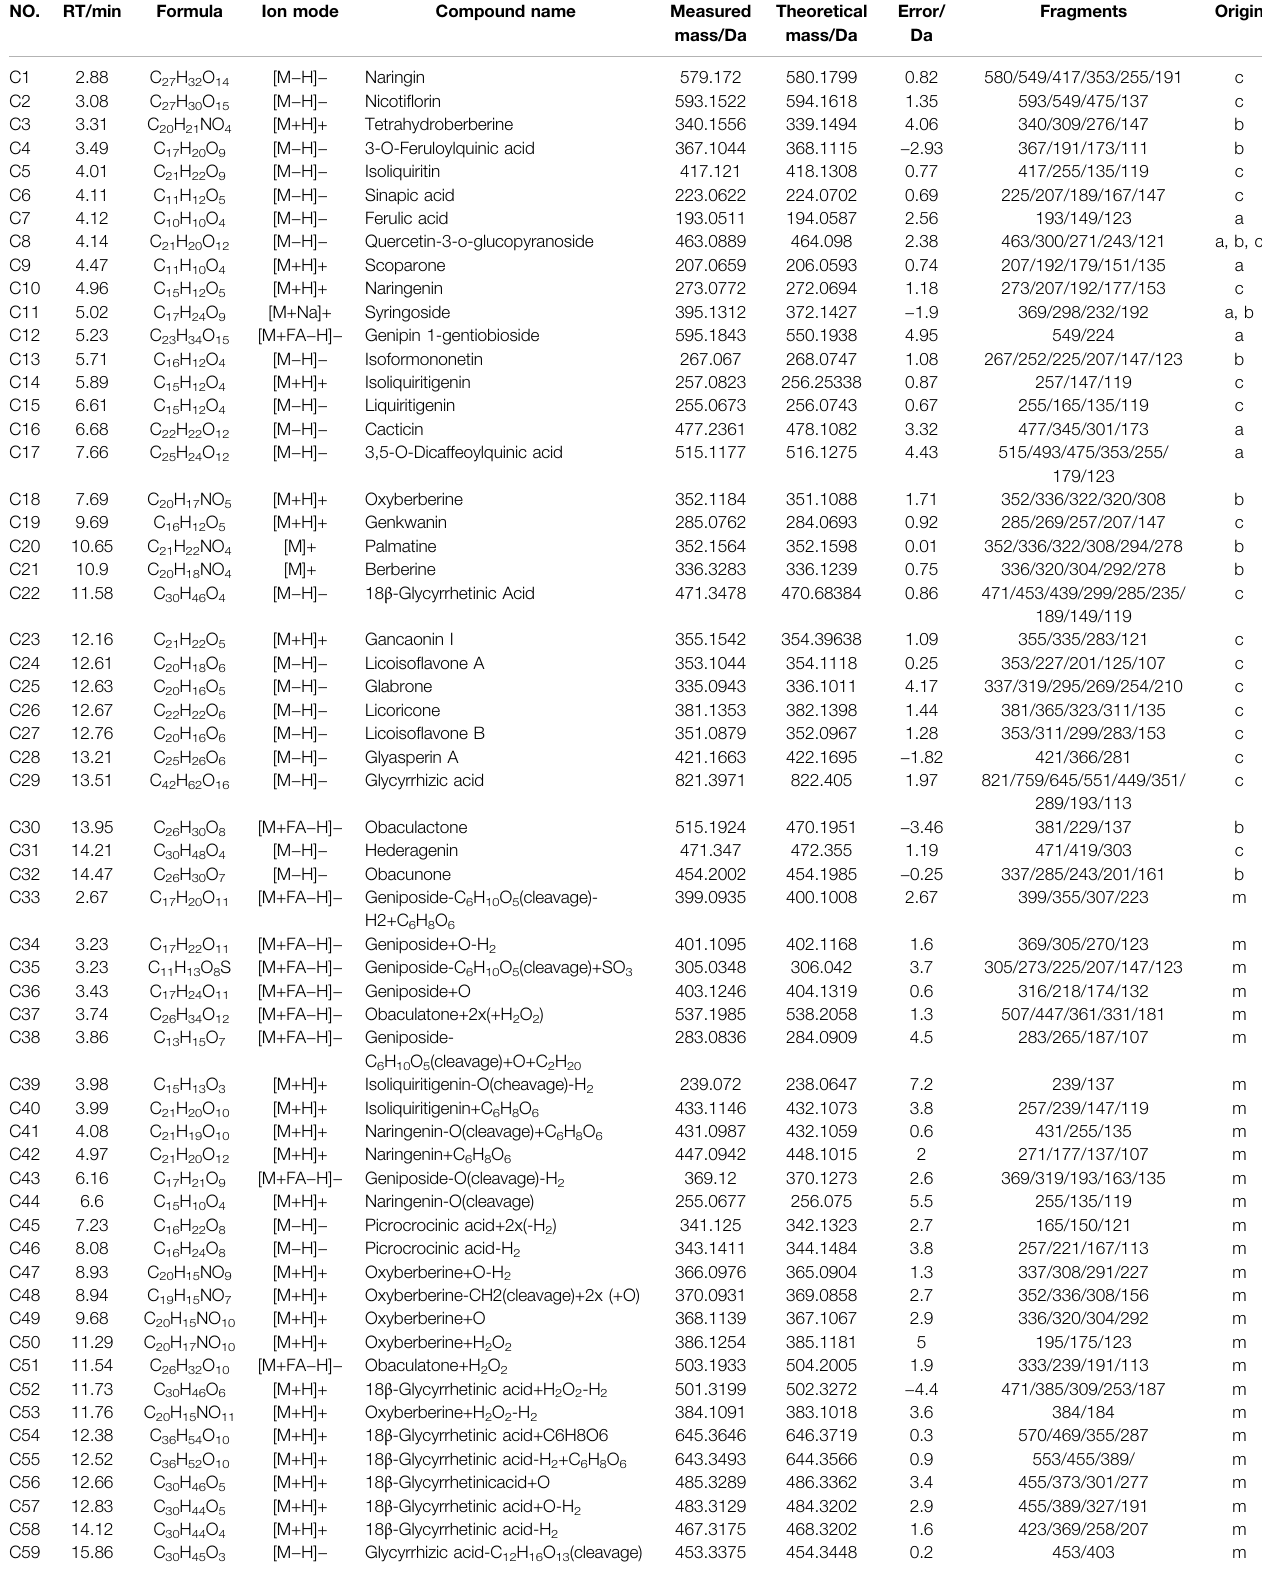
TABLE 2 | Analysis of constituents in DHJS rat serum after the oral administration of